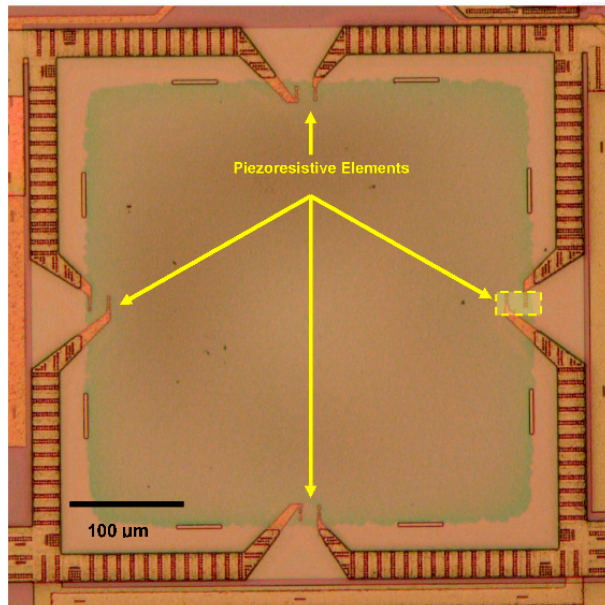
Figure 4. Square membrane pressure sensor in the multi-sensor SOI CMOS MEMS chip. The membrane is made of SiO 2 and has a side length of 400 µm. The cadence layout of the boxed piezoresistor is shown in Figure 6.